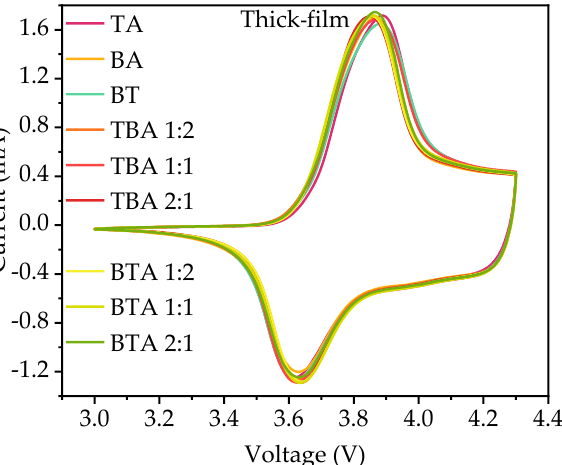
Figure 5. The CV measurements of the coin cells with unstructured single-layer and bilayer electrodes.